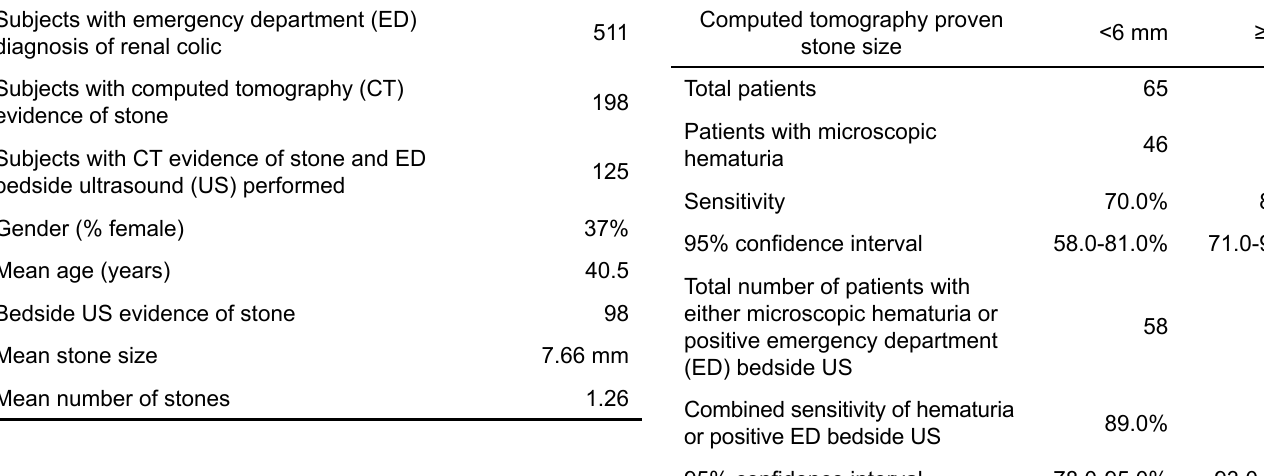
Table 1. Characteristics of study subjects.